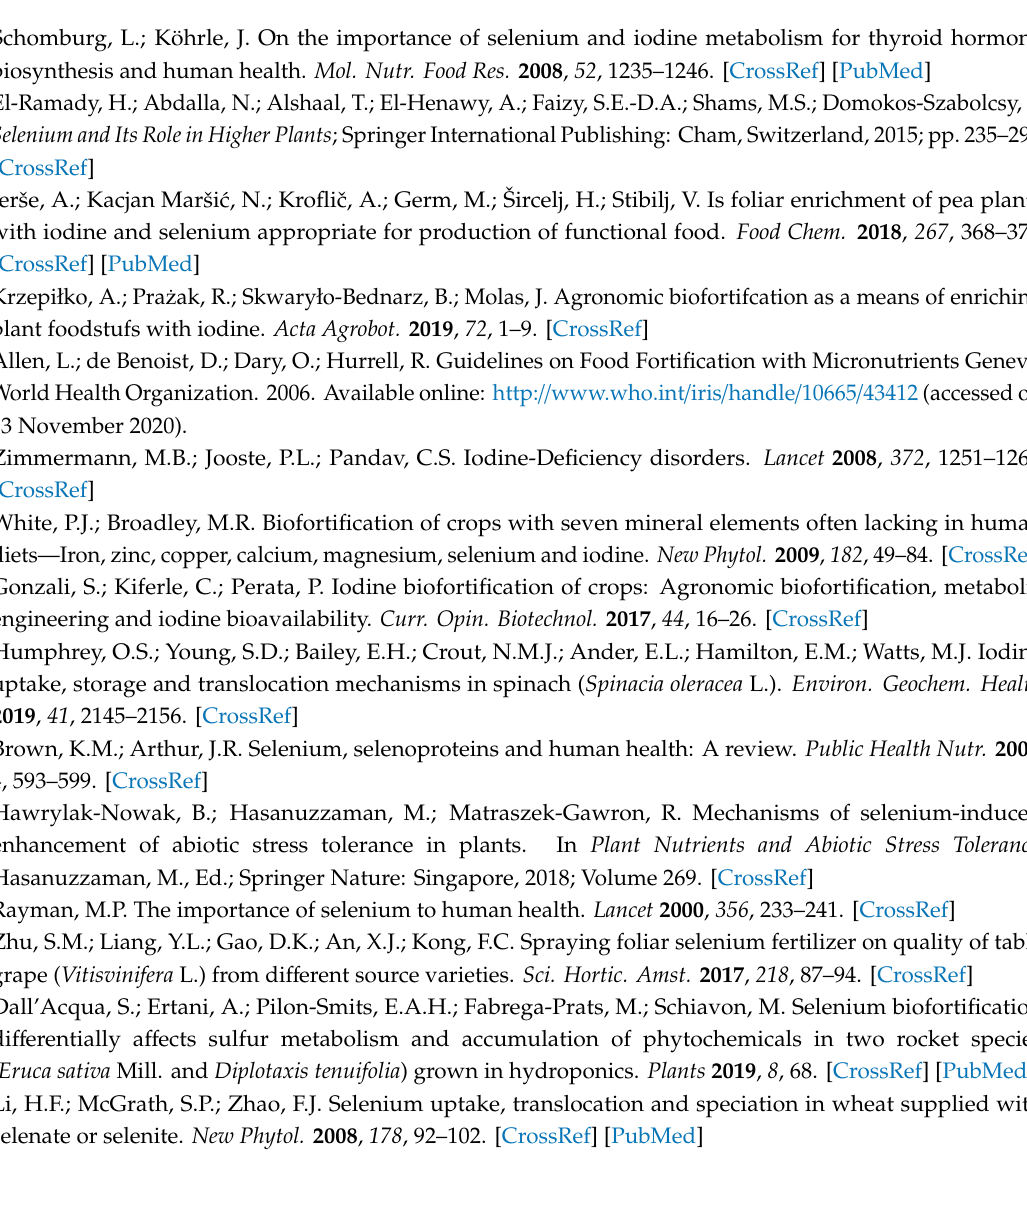
Table S1: Weather conditions during the field